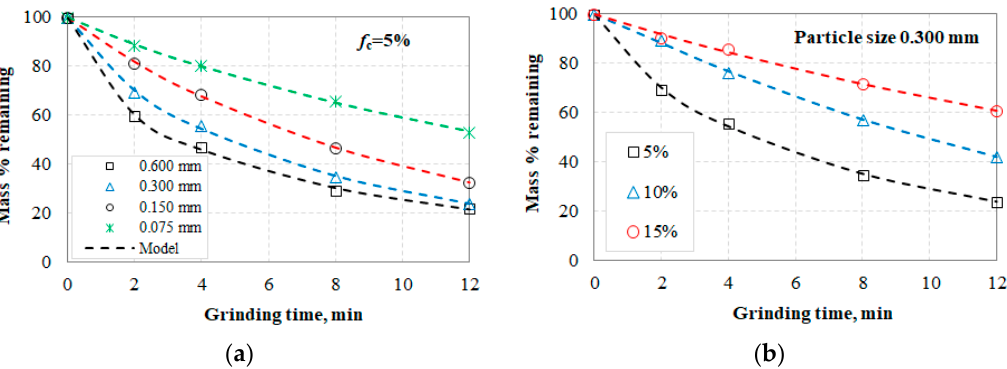
Figure 5. Remaining mass fraction (wt%) vs. grinding time for ( a ) four selected sizes when f c = 5% and ( b ) particle size 0.300 mm when diferrent f c values (5%, 10% and 15%) were used. Table 3. Parameters of Alyavdin formula (Equation (1)) for particle size 0.300 mm at different f c values.